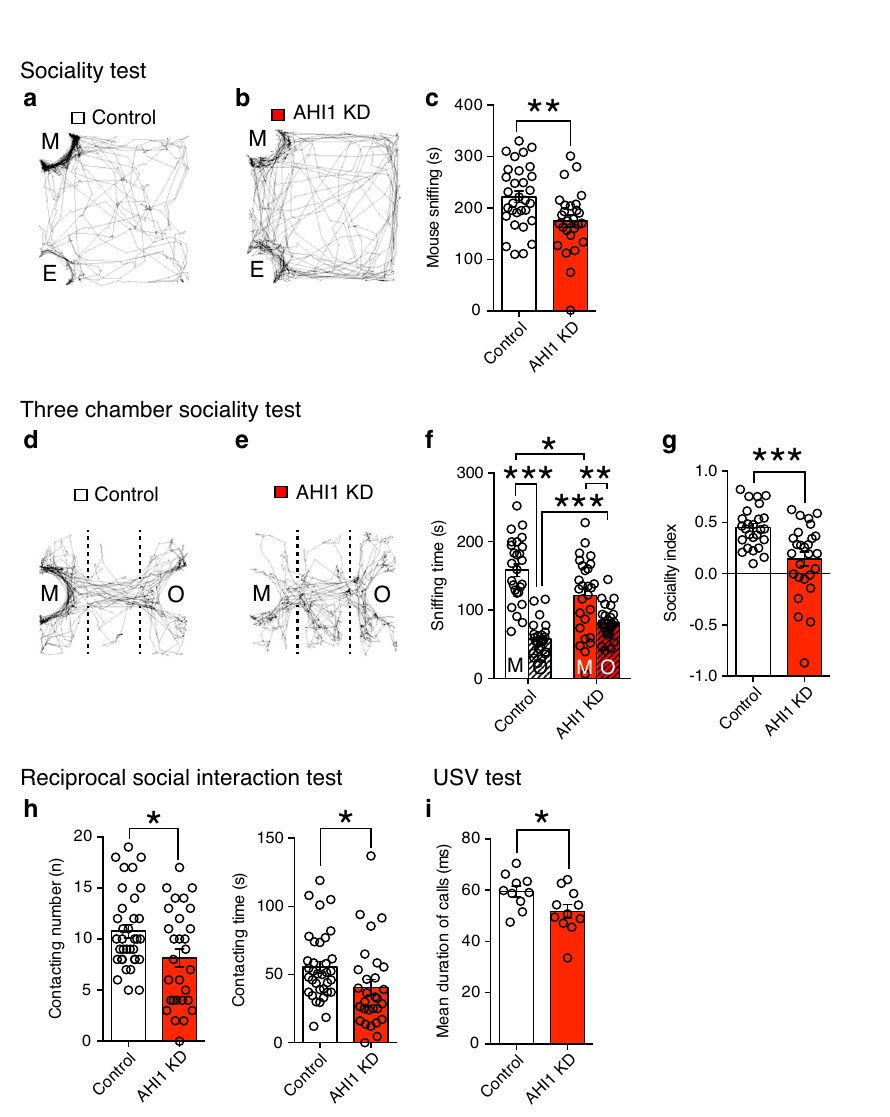
Fig. 4 Effects of AHI1 knockdown in layer 2/3 pyramidal neurons of the PFC on ASD-like behaviors. a – c Representative tracks ( a , b ) and summary graphs showing the amount of time snif fi ng the novel mouse (M) ( c ) for AHI1-scramble (control) (white columns, n = 31) and AHI1-KD (red columns, n = 27) mice. d – g Representative tracks ( d , e ) and summary graphs showing the amount of time snif fi ng the novel mouse (M) and the novel object (O) ( f ) and sociality index ( g ) for control (white columns, n = 26) and AHI1-KD (orange columns, n = 27) mice. h Contacting number and time in control (white column, n = 35) and AHI1-KD (red column, n = 29) mice. i Duration of calls in control (white column, n = 10) and AHI1-KD (red column, n = 11) pups. *P < 0.05, ***P < 0.001 (Student ’ s t test or Paired t test). Data are mean ± SEM. Source data are provided as a Source Data fi